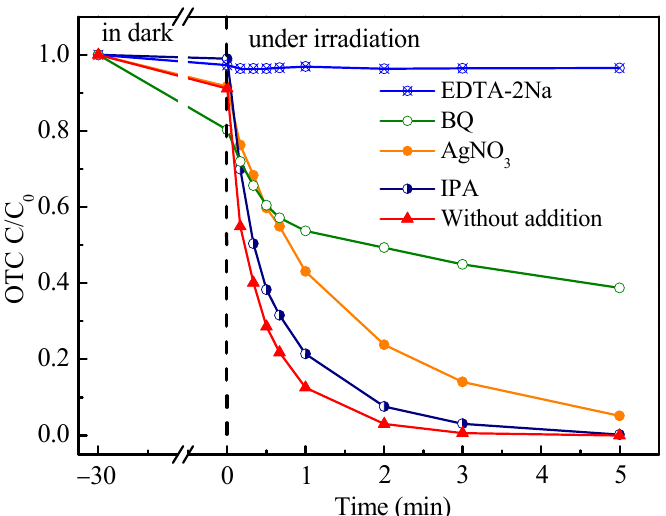
Figure 8. Degradation curve of oxytetracycline by Ag 3 PO 4 @5 mL NDC composite photocatalyst in the presence of different free radical traps.